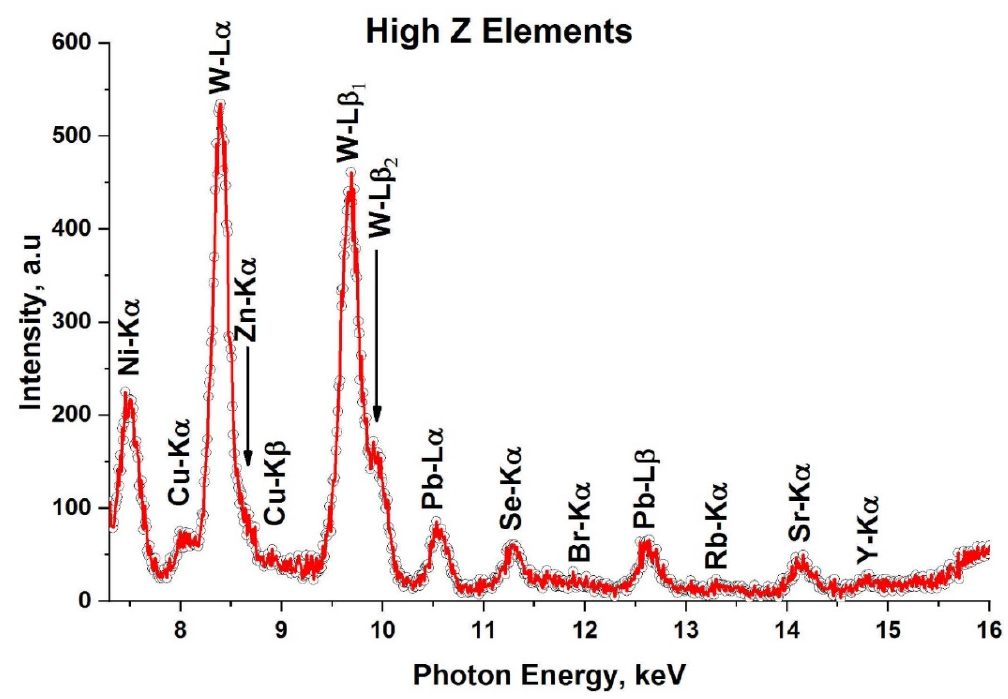
Figure 7. The EDXRF spectrum of the high Z elements using Mo secondary target for selected PM 2.5 sample from historical Jeddah district, Saudi Arabia.